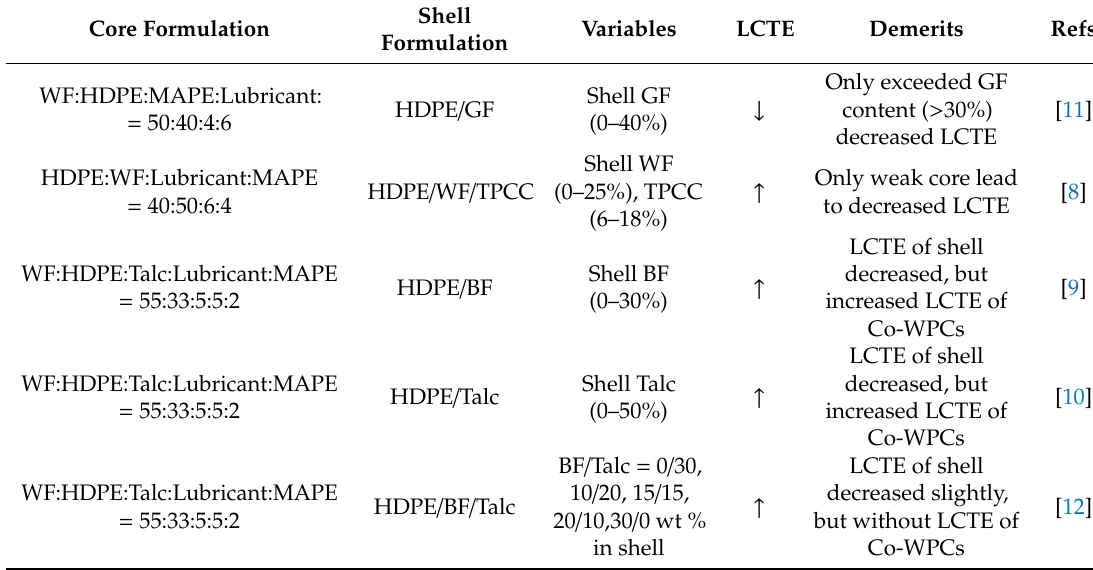
Table 1. Summary of combinations of core–shell layer fillers and their e ff ects on the thermal expansion of co-extruded wood / polyethylene composites (Co-WPCs). Shell Core Formulation Formulation